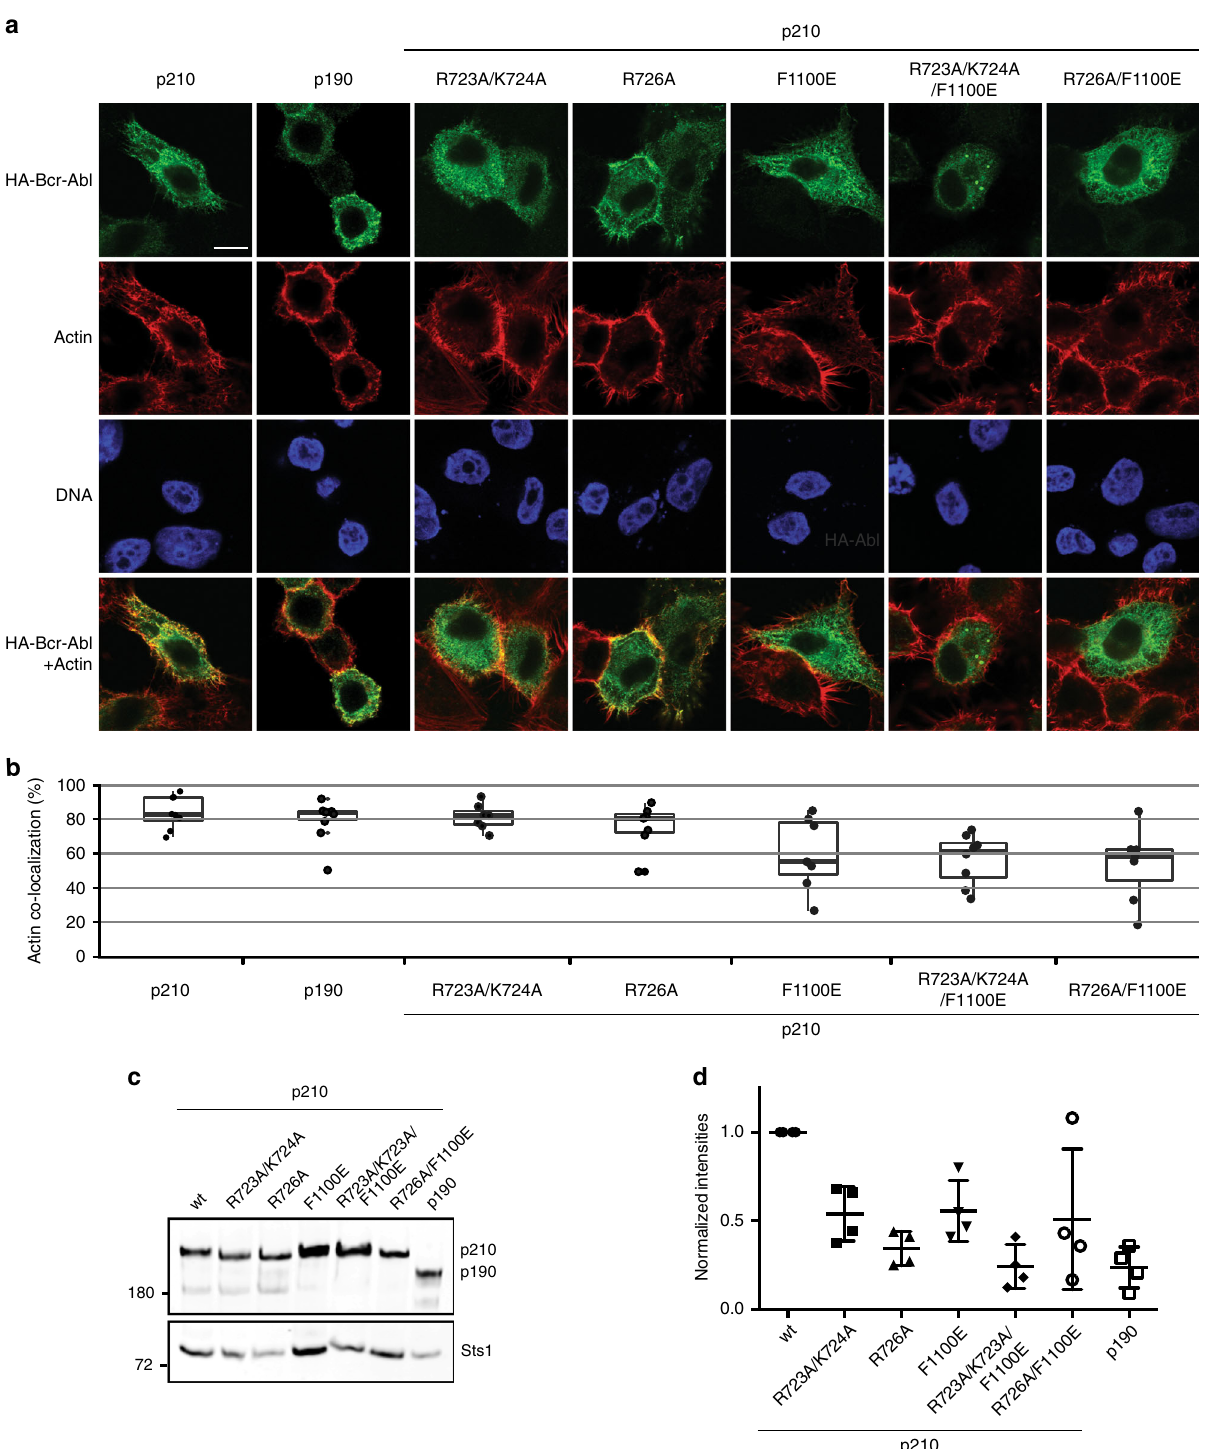
Fig. 6 Localization and signaling network of Bcr-Abl p210, p190, FABD and PH mutant proteins. a Cellular localization of Bcr-Abl p210 and p190, p210 with the PH mutations R723A/K724A or R726A, with the FABD mutant F1100E, as well as a combination of PH and FABD mutation. Cells were fi xed and immunostained with an anti-HA antibody (HA-Bcr-Abl). F-actin (actin) and nuclei (DNA) were stained with rhodamine-conjugated phalloidin and Hoechst, respectively. The white scale bar in the upper left image corresponds to 10 µ m. b Quanti fi cation of co-localization of Bcr-Abl with actin fi bers using ImageJ. The box-and-whisker plots show the median, lower/upper quartile, and minimum/maximum of % Actin co-localization for at least six quanti fi ed cells per Bcr-Abl mutant. c Representative immunoblot analysis of anti-Bcr-Abl/Abl immunoprecipitates from BaF3 cells stably transduced with the indicated Bcr- Abl variants. Fractions of the immunoprecipitates were immunoblotted for Bcr-Abl and its interaction partner Sts1. d Quanti fi cation of the co-immunoprecipitation of Sts1 with Bcr-Abl. The quanti fi ed amount of co-immunoprecipitated Sts1 after correction for the Bcr-Abl amounts is shown. Means ± s.d. of two biological replicates analyzed in two technical